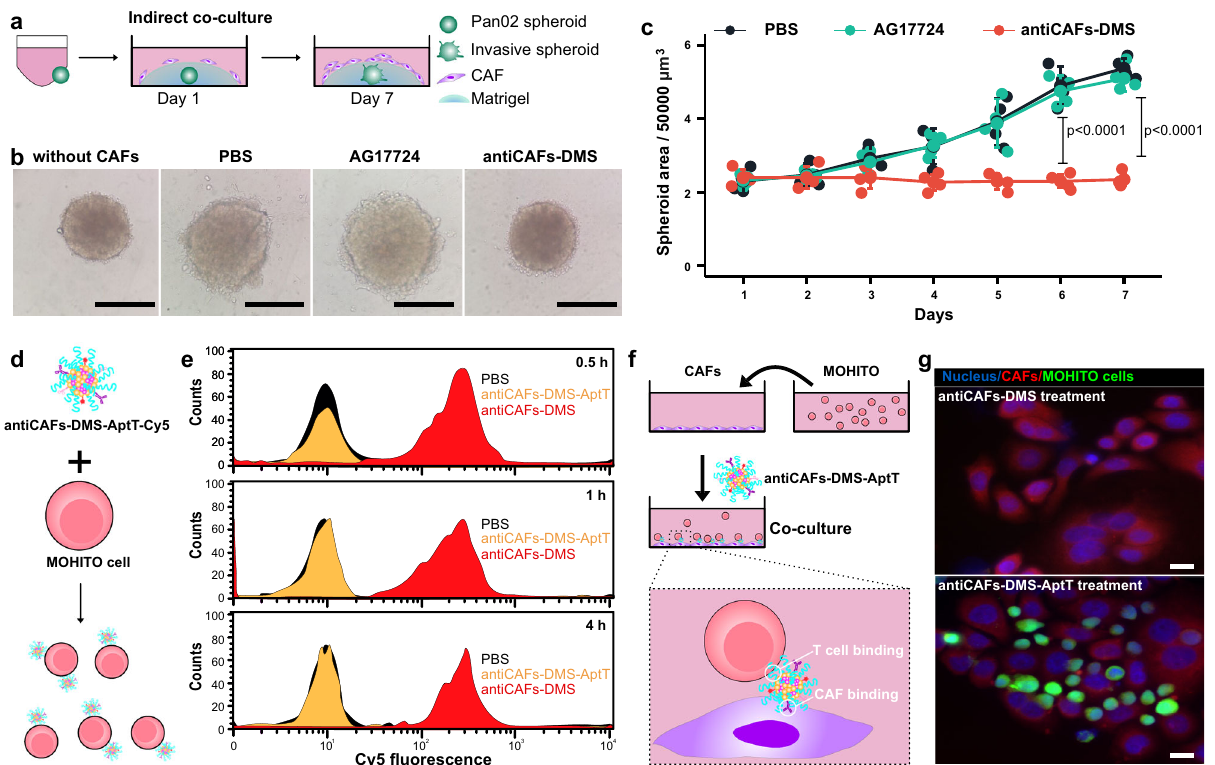
Fig.4|CancercellsandT-cellengagementviabispeci fi cantiCAFs-DMS-AptTin 3D and 2D models. a Schematic work fl ow of Pan02 spheroids and CAFs indir- ectco-culture. b RepresentativemorphologicimagesofPan02spheroidsattheend of the indirect co-culture. Scale bars are 100 μ m. c Dynamic growth curves of Pan02 spheroids during the indirect co-culture ( n =5 biologically independent spheroids; Error bars, mean±SD). Two-tailed Student ’ s t tests. d Schematic work- fl ow of the incubation of MOHITO cells with Cy5-labeled antiCAFs-DMS-AptT.